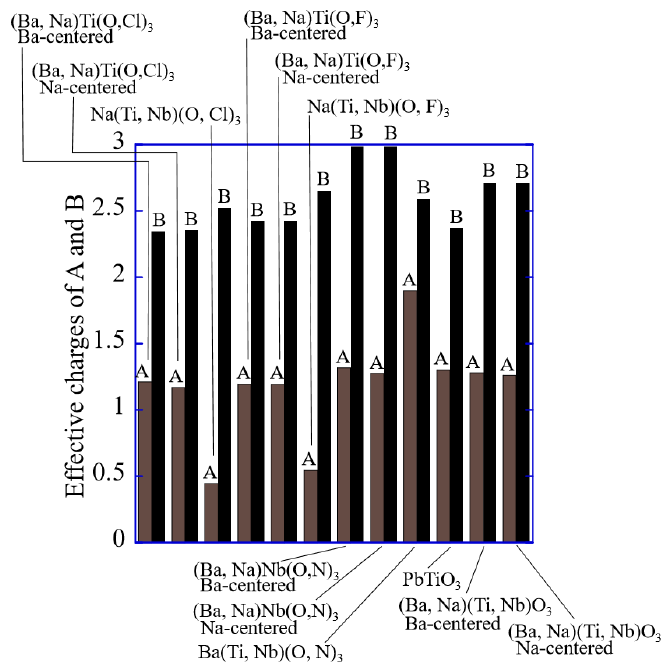
Figure 8. Histogram of the effective charges of A and B of cluster model (Ba, Na)(Ti, Nb)O 3 replaced with Cl, F, N, respectively. The values in Table 8 were used. The values of PT in Table 5 and (Ba, Na)(Ti, Nb)O 3 in Table 7 were also used for comparison.